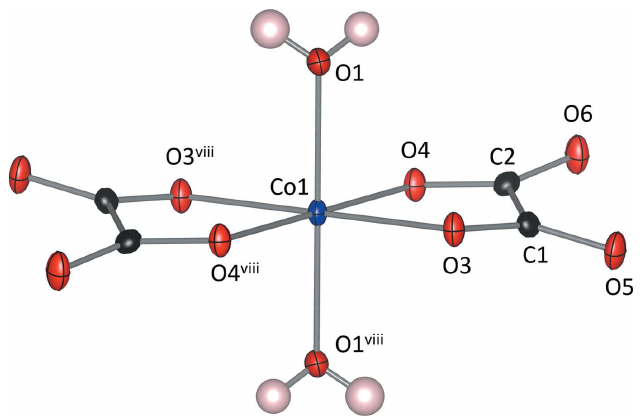
Figure 1 Coordination environment of Co 2+ in Rb 2 Co(C 2 O 4 ) 2 (cid:2) 4H 2 O (I). Colour code: Co (blue), C (black), O (red) and H (light pink). Displacement ellipsoids are drawn at the 50% probability level. [Symmetry code: (viii)